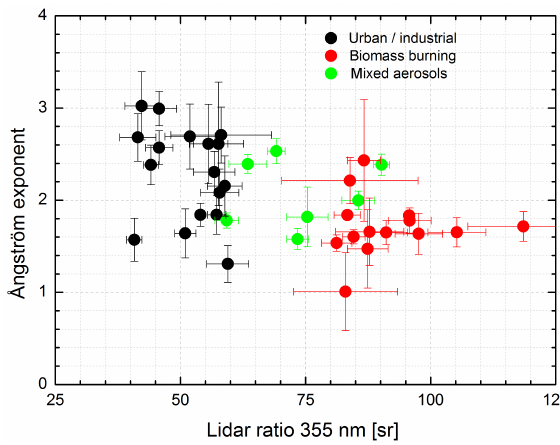
Figure 5. Lidar ratio at 355nm vs. the extinction-related Ångström exponent from 355 to 532nm for the three aerosol types investi- gated in our